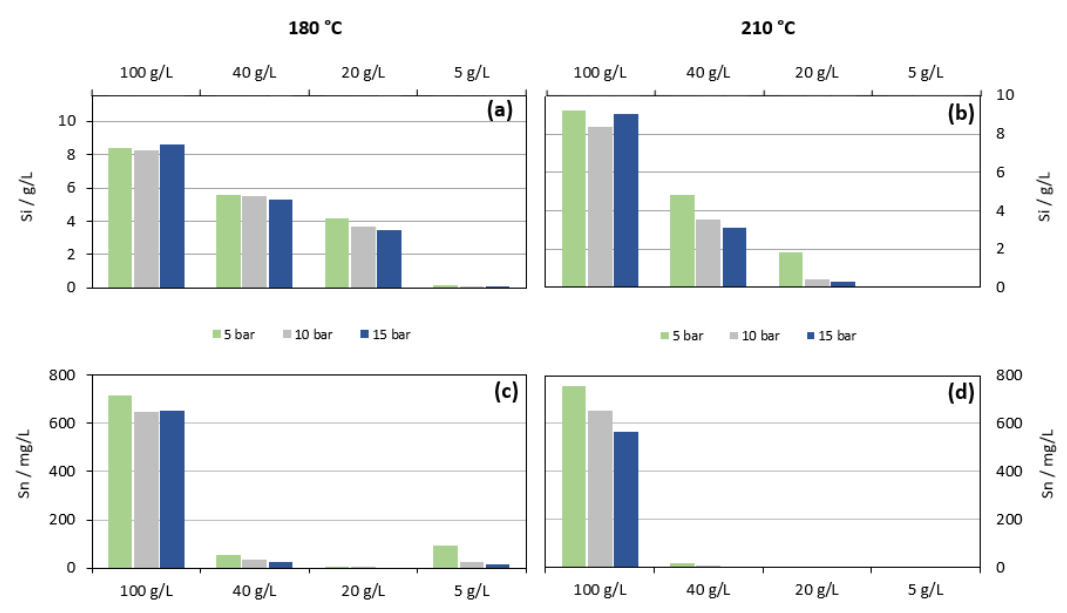
Figure 11. The silicon concentration in the liquor at 180 °C ( a ) and 210 °C ( b ); the tin concentration in the liquor at 180 °C ( c ) and 210 °C ( d ); constants: 1 h, 800 rpm, S/L: 0.1.